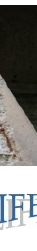
Figure 3. Anagram of Concrelife.